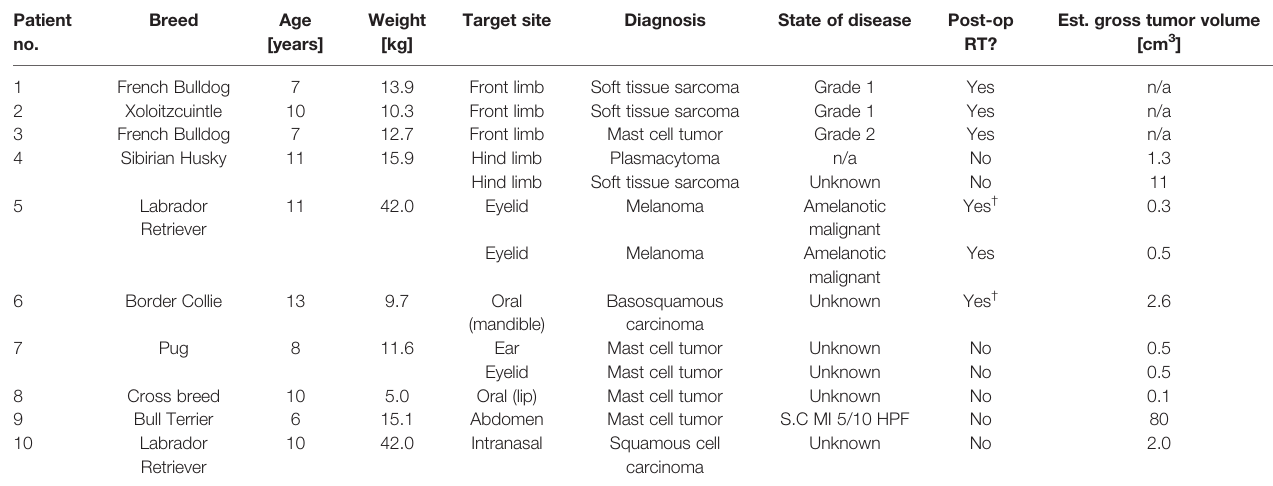
TABLE 1 | Description of the ten canine patients. Patient